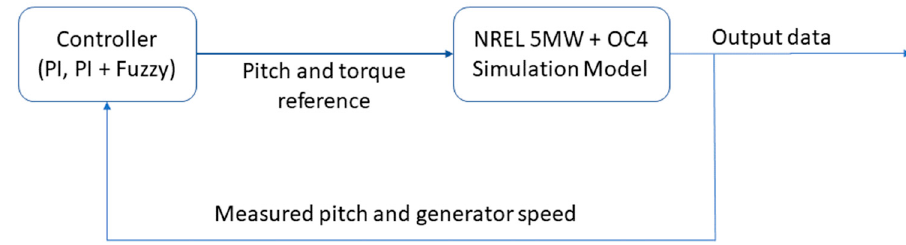
Figure 1. Closed-loop scheme of the controller.